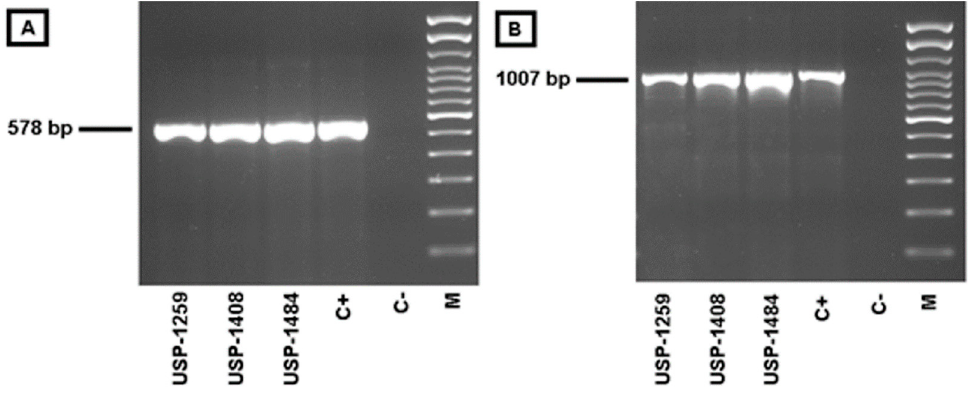
Figure 8. Electrophoresis for APV. ( A ) PCR for P4b APV gene. ( B ) PCR for pol APV gene. C+ = positive control, C − = negative control, M = molecular size marker (100 bp).